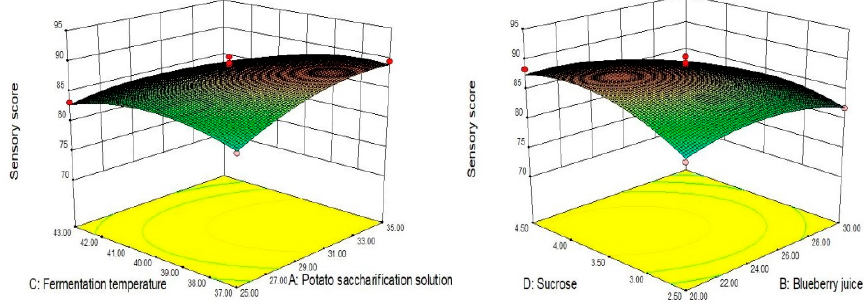
Figure 3. The 3D response surface for the results of the sensory score.